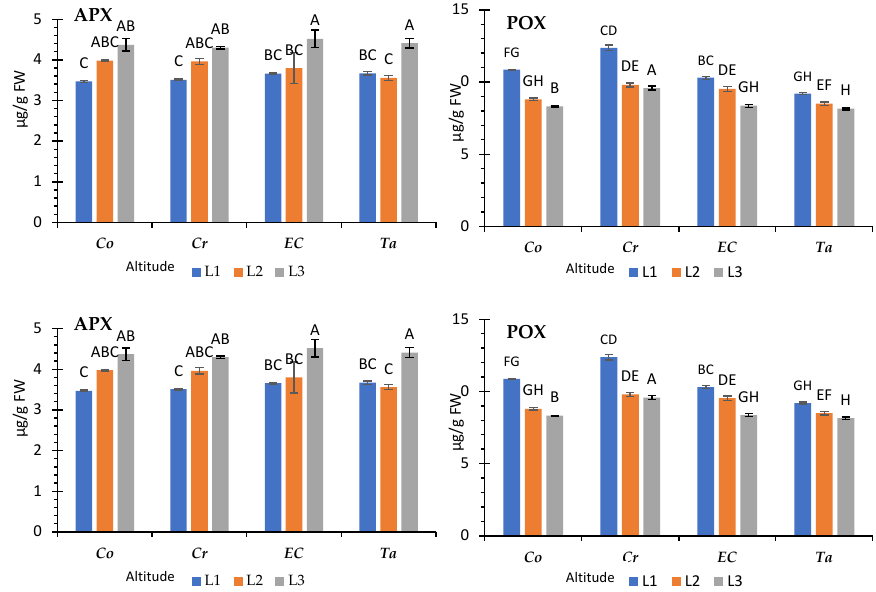
Figure 6. The activities of some antioxidant enzymes, including catalase (CAT), super oxide dis ‐ mutase (SOD), ascorbate peroxidase (APX), and peroxidase (POX) in the leaves of the target species from different altitudes. Each value is the mean of three replicates ± SE. At p ≤ 0.05, bars with differ ‐ ent letters are significantly different. Abbreviations: L1 = altitude 1; L2 = altitude 2; L3 = altitude 3; Co . = Cotineaster orbicularis ; Cr. = Crataegus sinaica; Ec. = Echinops spinossissmus; Ta. = Tanacetum si ‐ naicum.